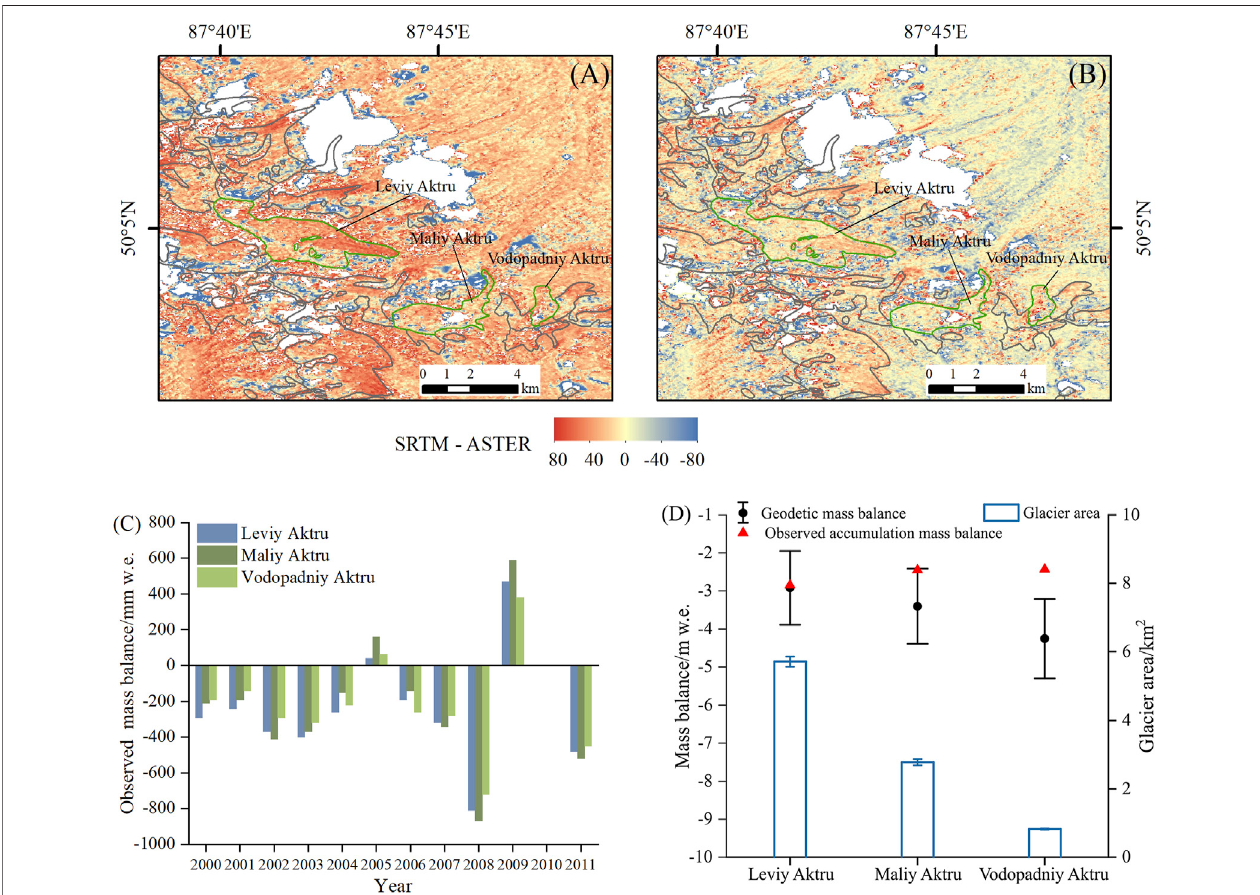
FIGURE4|(A) Originalelevation difference ofmonitoring regionfrom 2000to2011. (B) Adjusted elevation difference ofmonitoring regionfrom 2000to2011. The white part (null value) is over high elevation differences caused by clouds, which were removed by threshold. (C) Observed mass balance of monitoring glaciers during 2000 – 2011. (D) Observed accumulation mass balance and geodetic mass balance of monitoring glaciers during 2000 –